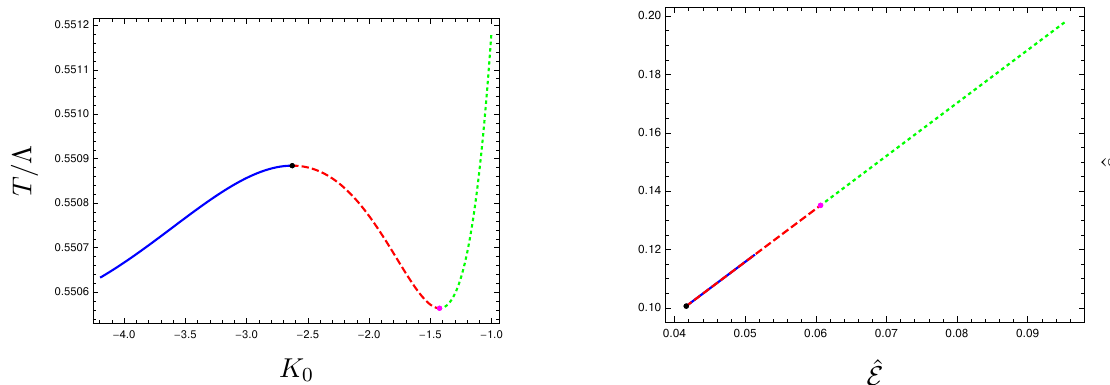
Figure 36 . Physical observables of conifold black holes, here the Klebanov-Tseytlin black hole at µ = µ 2 (6.18), can depend on the numerical parameters ( K 0 in the left panel) non-monotonically. Some of this non-monotonicity, when translated to physical observables as in the right panel, results in retracing the same states of the black hole: the blue solid curve folds onto the red dashed curve in the right